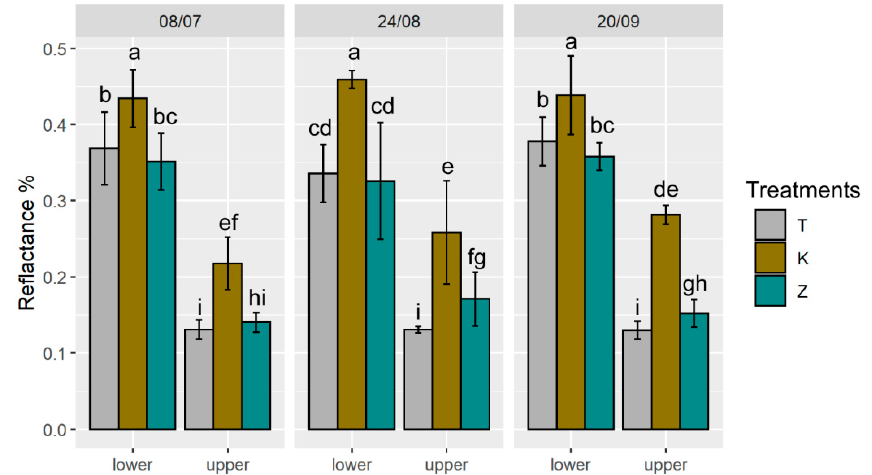
Figure 4. Mean reflectance between 400 and 700 nm measured on the lower and upper part of the leaves of T (control), K (kaolin) and Z (CHA-zeolitite) treatments. Error bars represent standard deviation. Different letters above the bars for each group of histograms indicate significant differences according to ANOVA and Tukey’s HSD test ( p < 0.05).